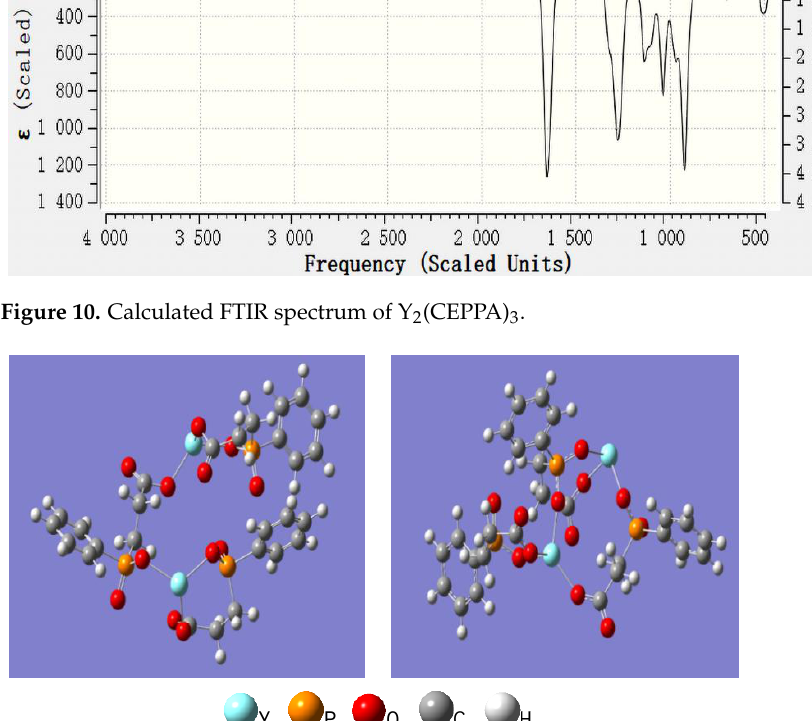
Figure 11. Building Y 2 (CEPPA) 3 structural model ( left ). Y 2 (CEPPA) 3 structural optimization model ( right ).